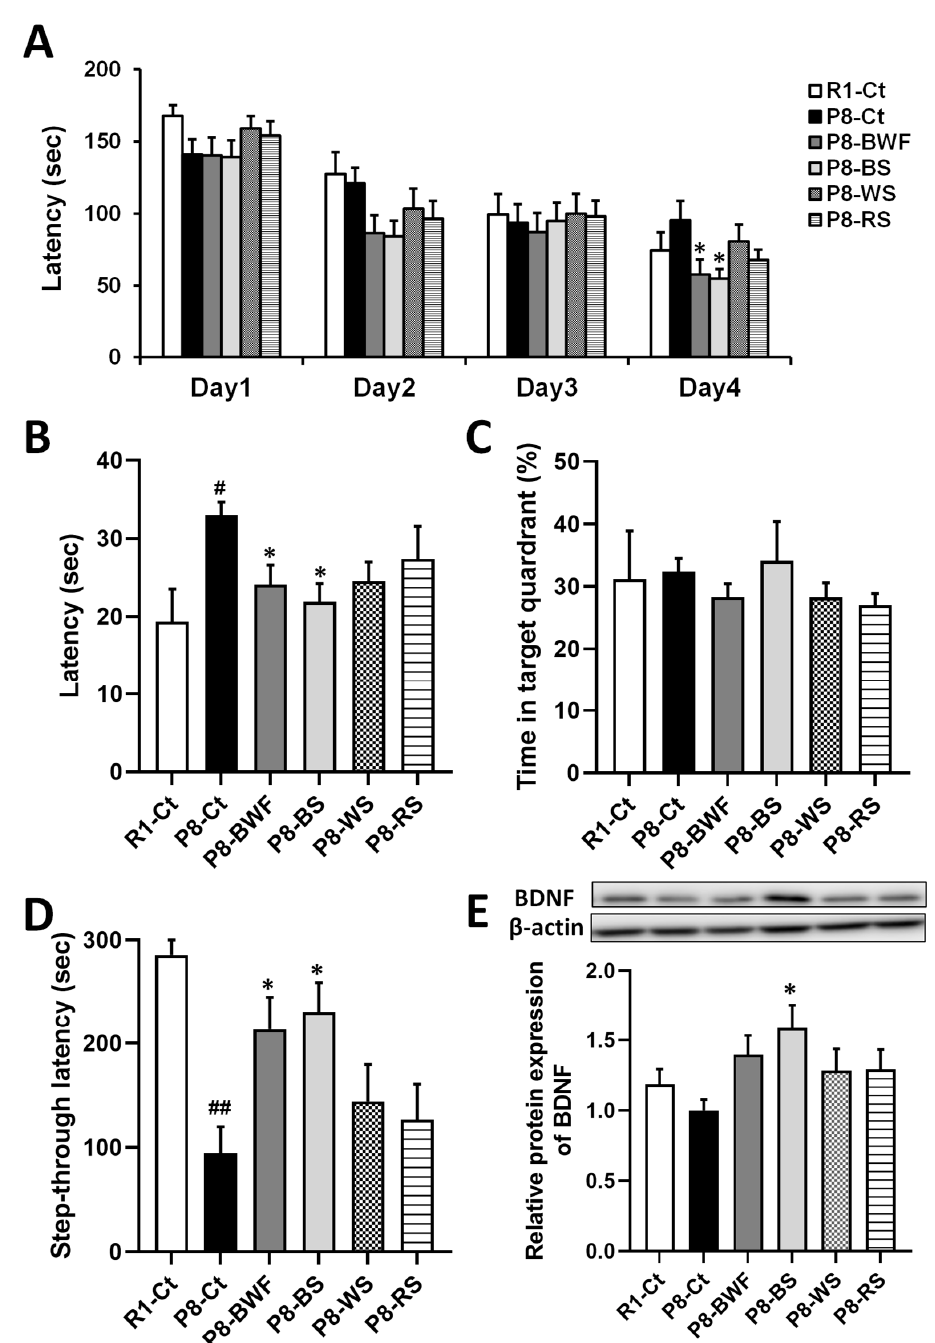
Figure 6. Effect of oral administration of various starch on learning and memory and hippocampal BDNF expression in SAMP8 mice. ( A ) Escape latency during training in the Barnes maze. ( B ) Escape latency during the probe test in the Barnes maze. ( C ) Time spent in target quadrant during the probe test in the Barnes maze. ( D ) Step-through latency in the passive avoidance test. ( E ) Representative image of the Western blot. β -actin was used as the internal control. Densitometric analysis of the band was expressed as relative fold compared with that in the P8-Ct group. Data are presented as the mean ± standard error of the mean ( n = 8 − 10). # p < 0.05, ## p < 0.01, compared with R1-Ct group. * p < 0.05 vs. the P8-Ct group. BS, buckwheat starch; WS, wheat starch; RS, rice